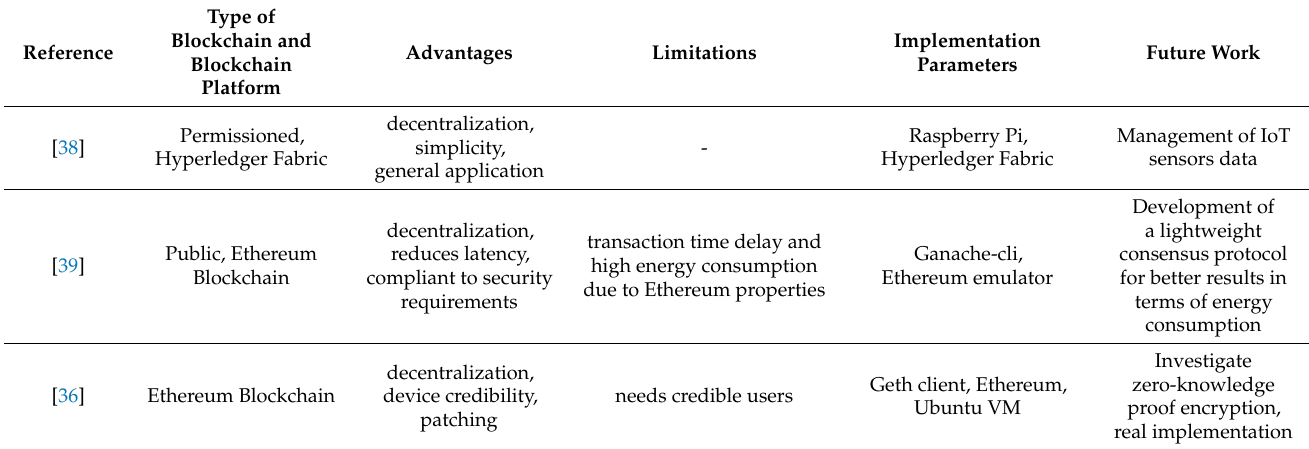
Table 2. Comparison of various blockchain-based authentication